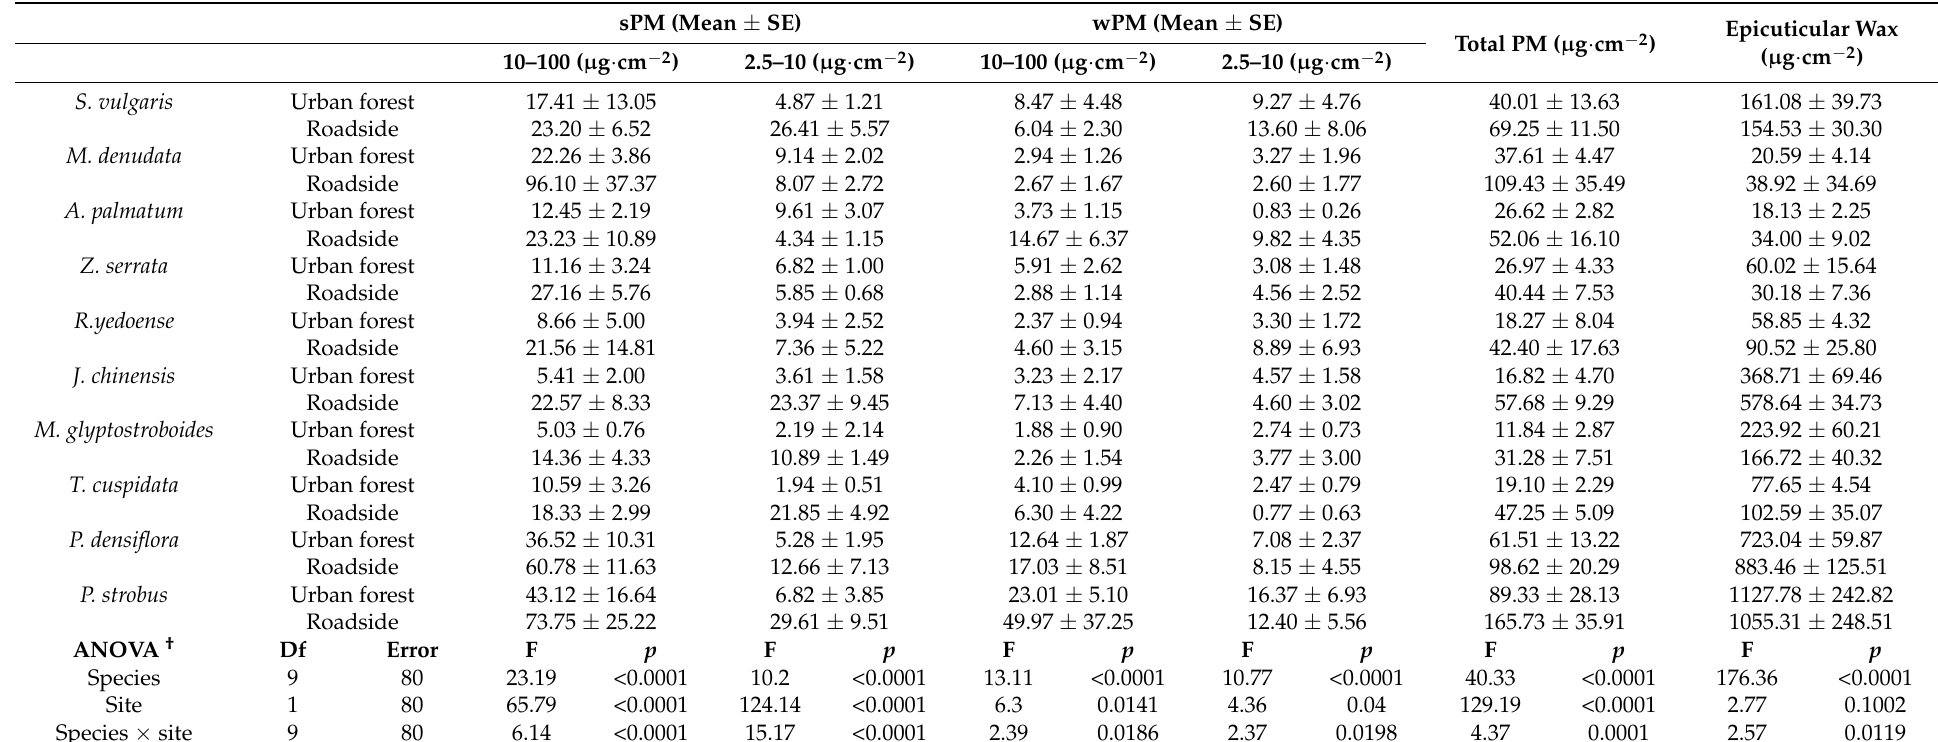
Table 2. Amount of particulate matter on leaf surface and epicuticular wax of 10 plant species from two